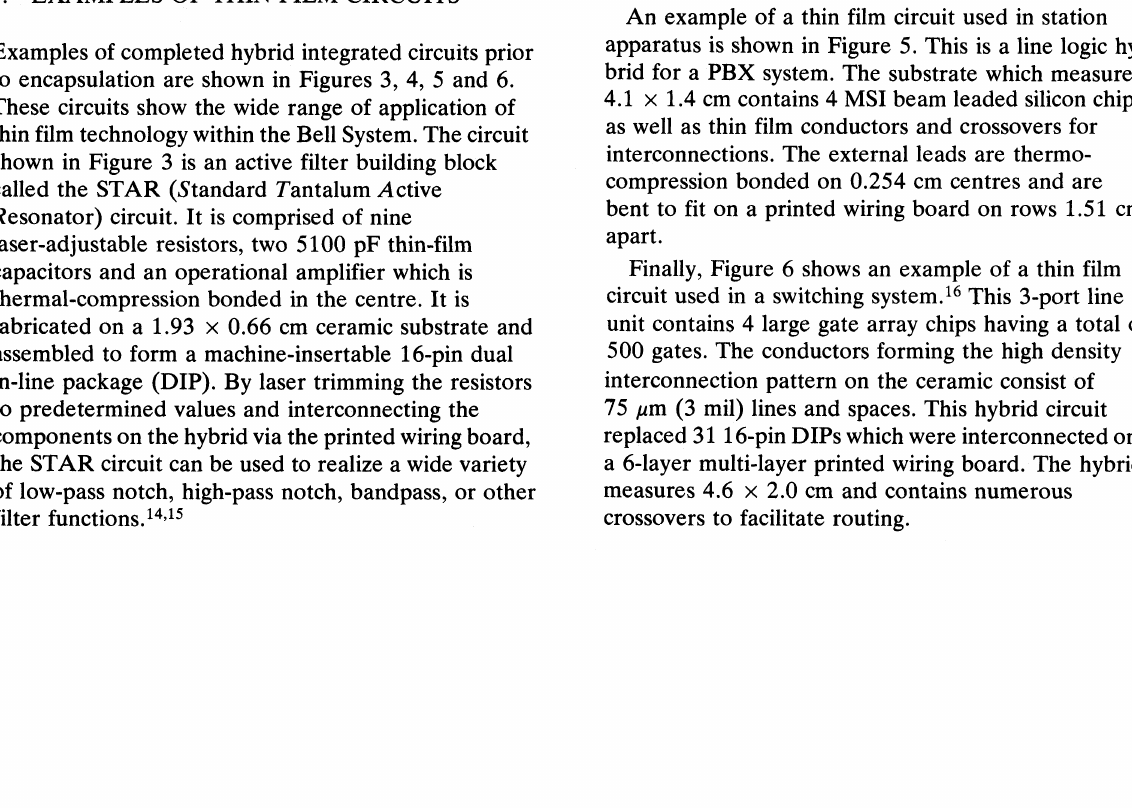
FIGURE 3 Thin film RC circuit used as an active filter building block (STAR).